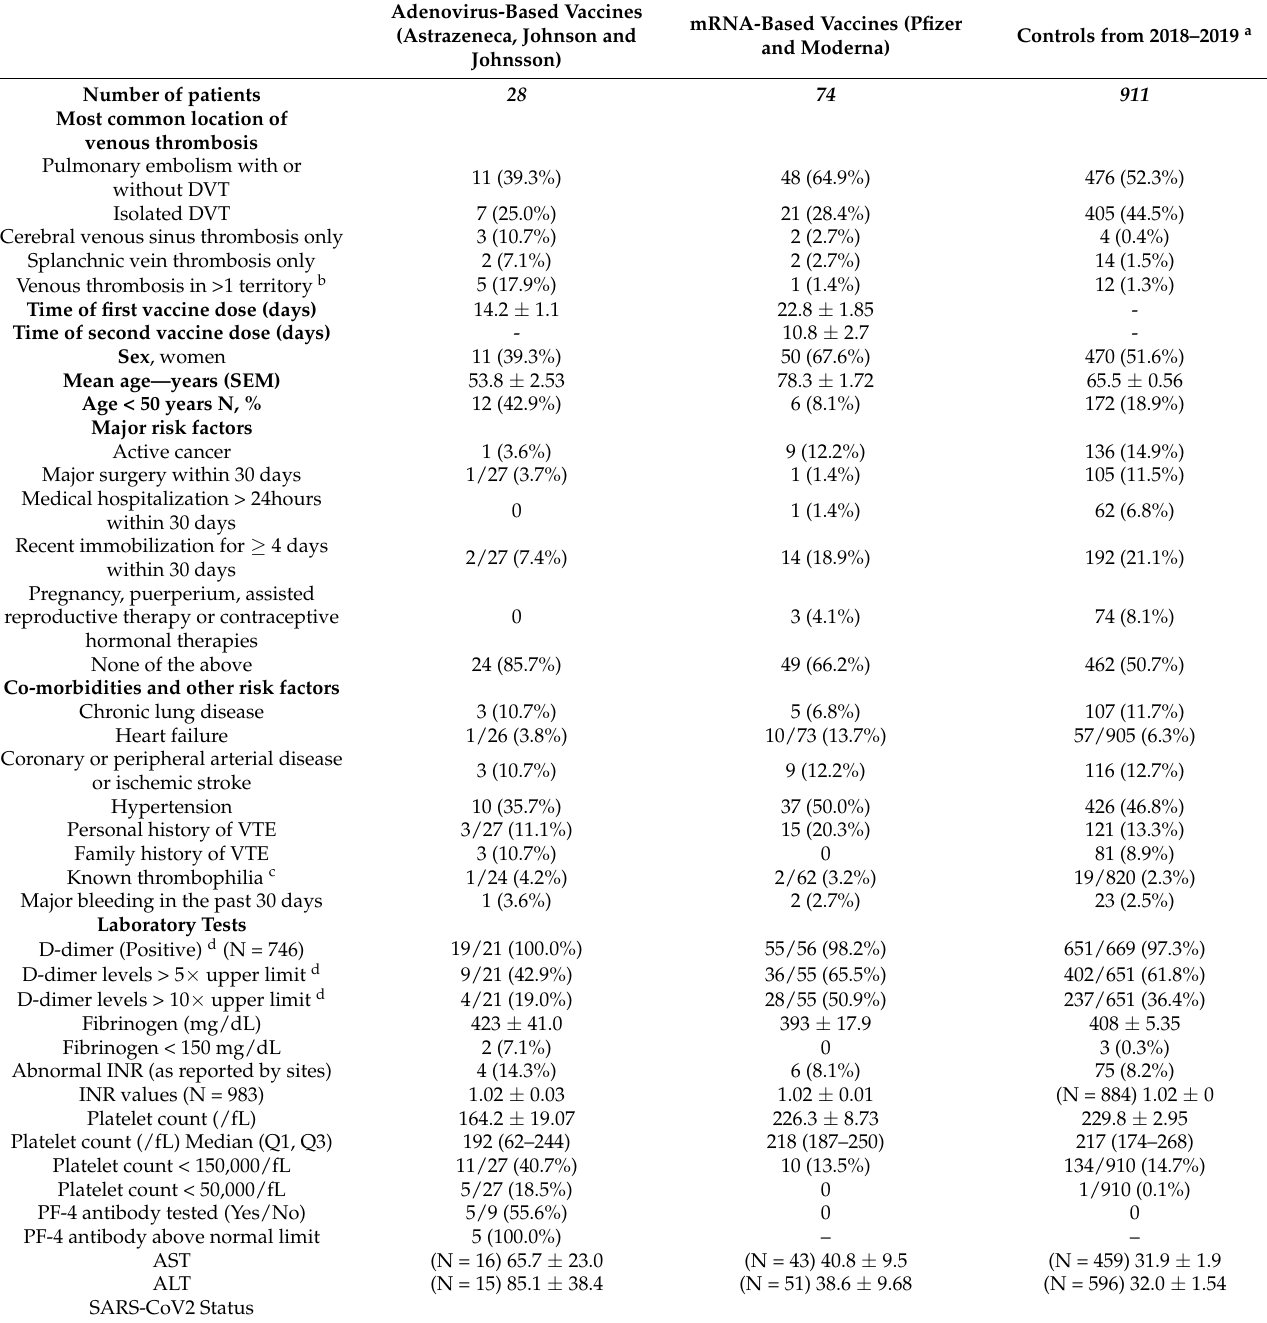
Table 1. Patient characteristics based on the type of COVID-19